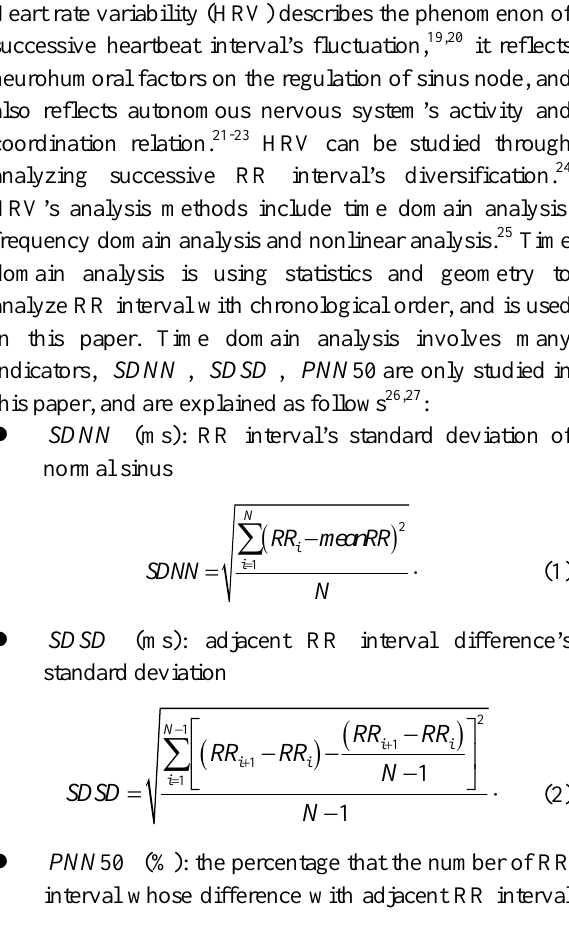
Fig.3. The acquisition interface of ECG signals